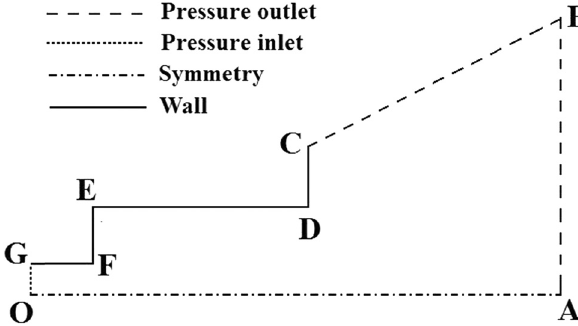
Figure 2: Boundary conditions and computational